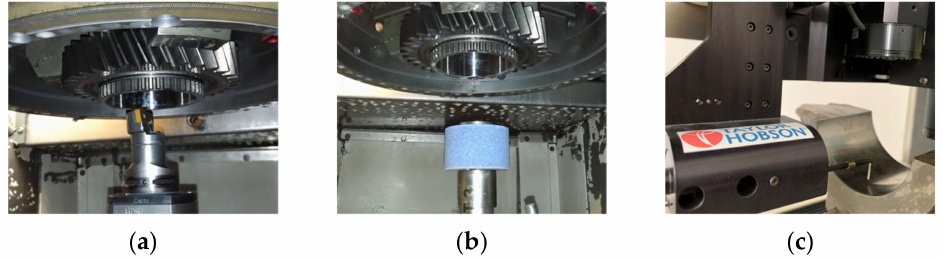
Figure 1. Machining and measurement setup of the workpiece: ( a ) hard turning, ( b ) infeed grinding, ( c ) measurement by inductive